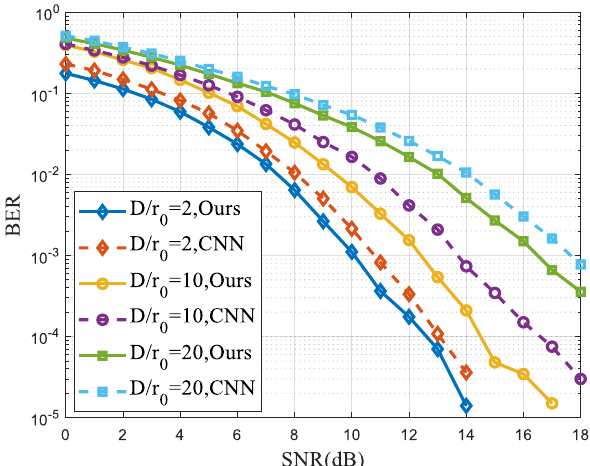
Figure 9. Comparison of system BER for different SNR and turbulence intensity.